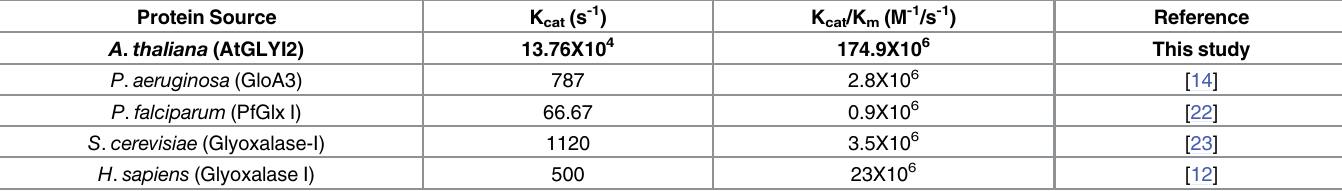
Table 3. A comparison of the kinetic parameters of AtGLYI2 (a Zn 2+ dependent GLYI) with Zn 2+ dependent GLYI from other species. Protein Source